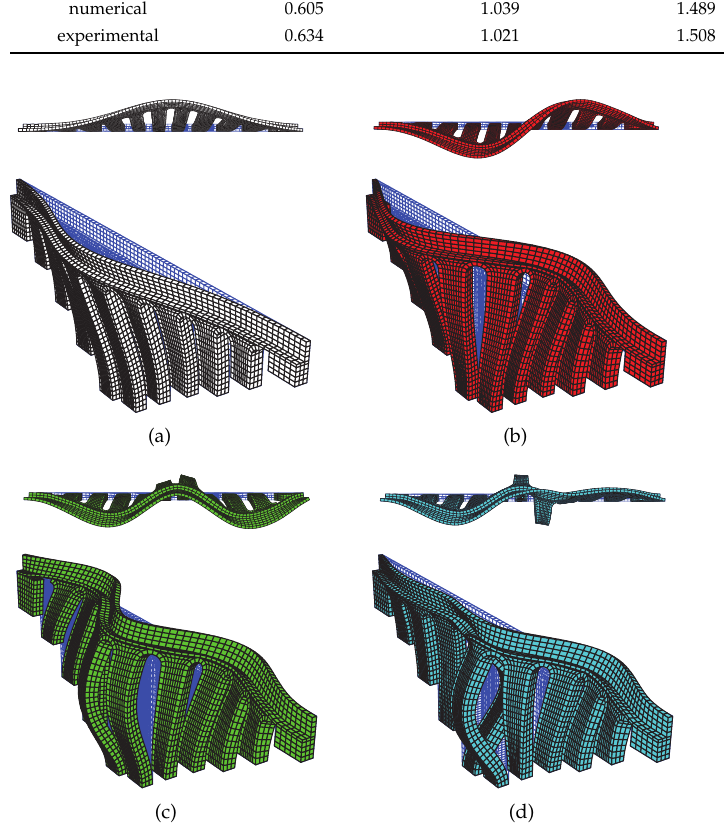
Figure 7. ‘Ponte delle Torri’: first four modal shapes corresponding to the frequencies in the first row of Table 3: ( a ) mode 1, ( b ) mode 2, ( c ) mode 3, ( d ) mode 4. 18.05